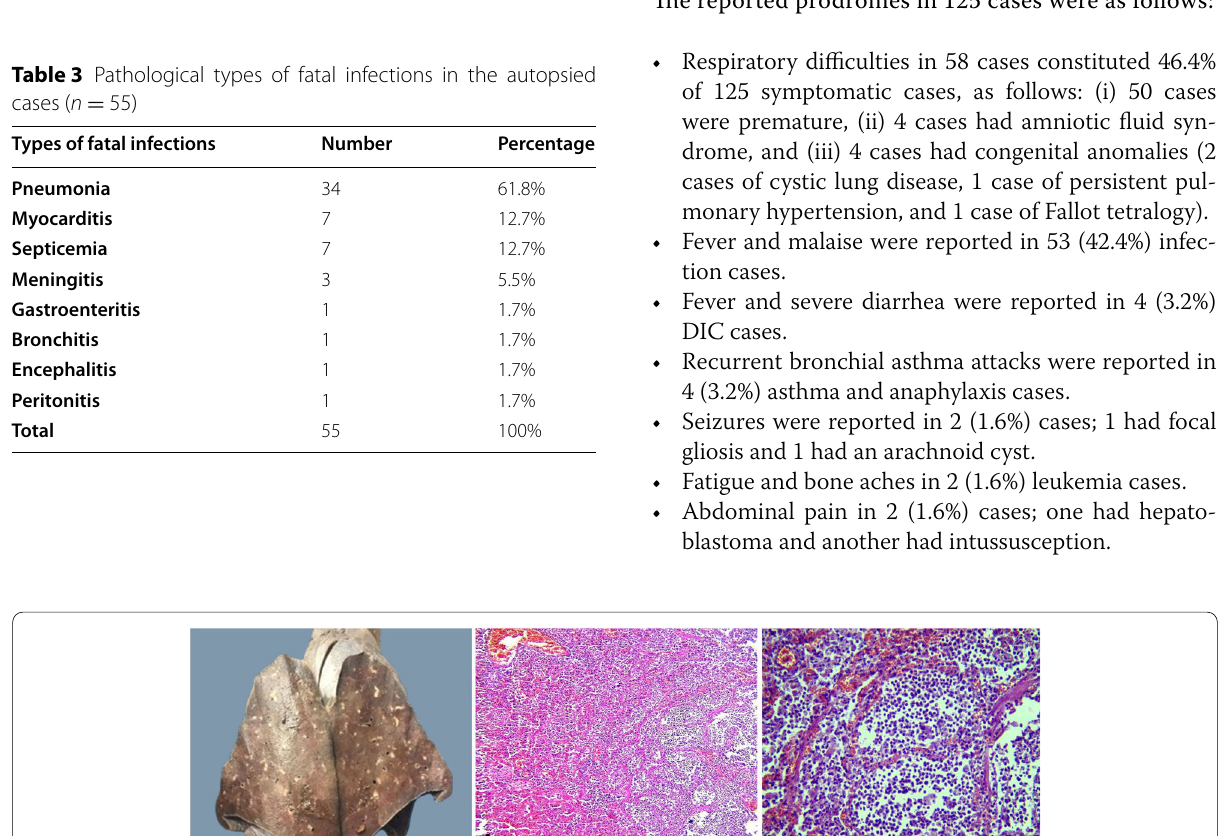
χ 2 Chi square test